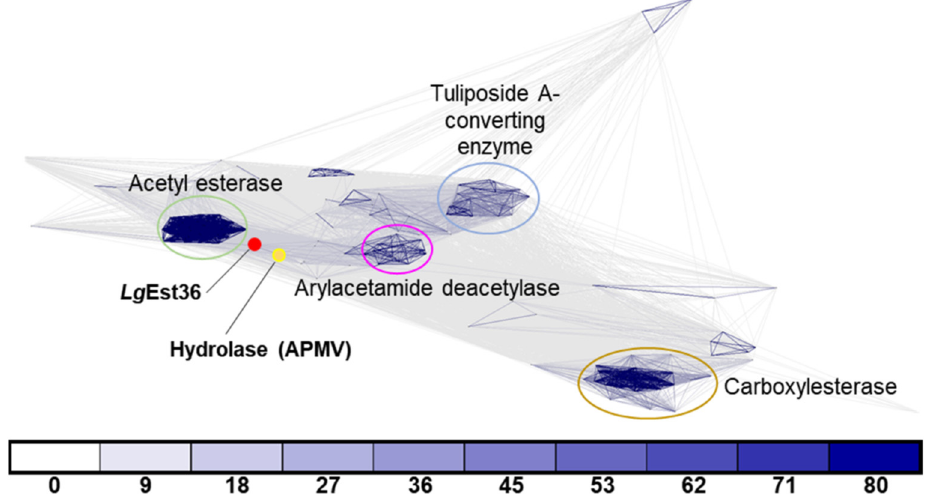
Figure 1. Sequences of orthologs from different species were used for clustering by CLANS clustering. ProtBLAST/PSI-BLAST was used to detect distantly related proteins using the Protein Data Bank (PDB) and Uniprot_sport databases. Lg EstI and the hydrolase (UniProt: Q5UQ83) from Acanthamoeba polyphaga mimivirus (APMV) within the UniProt database are indicated by red and yellow dots, respectively. Connecting lines of darker intensity and shorter length indicate higher sequence similarity. Connections with a p -value better than 1 × 10 –x are drawn in the corresponding color (x = number below).